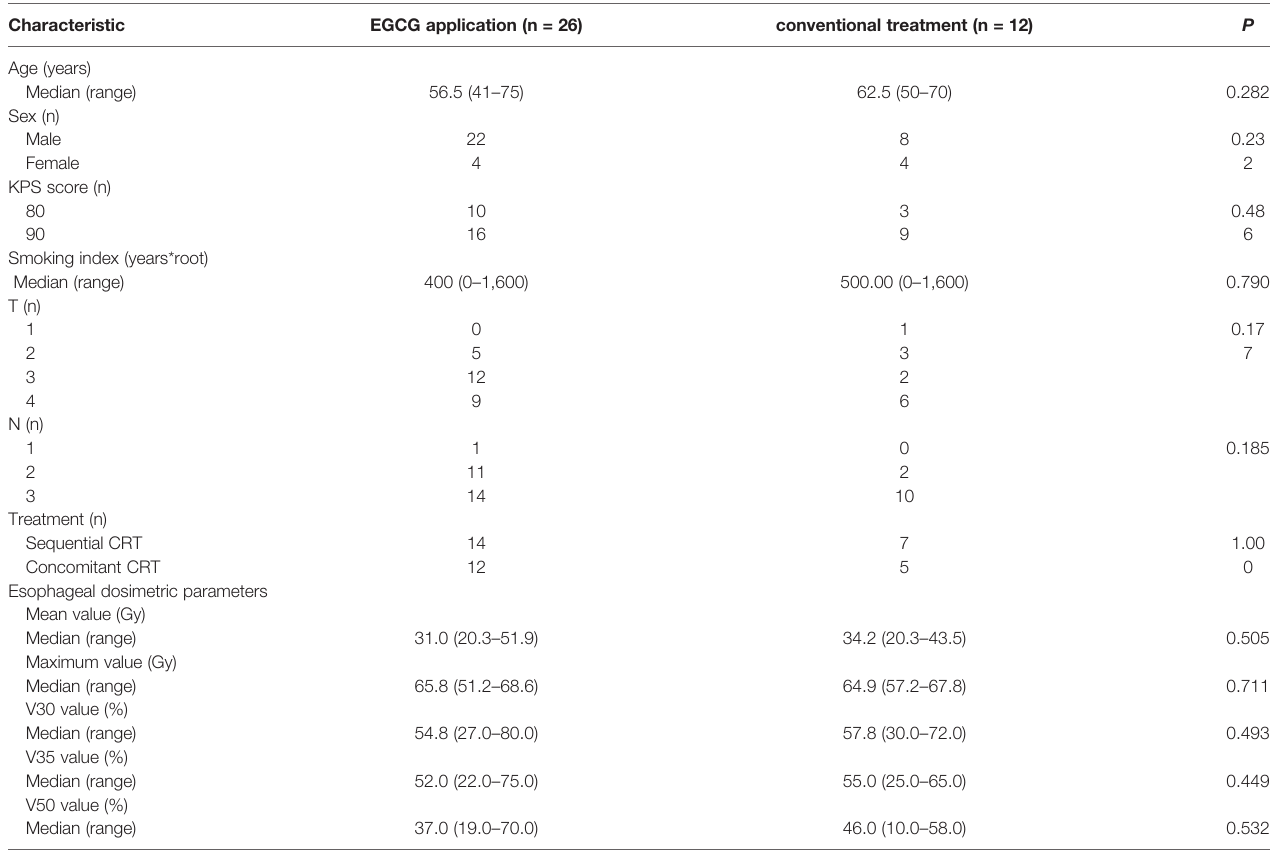
TABLE 1 | Pretreatment